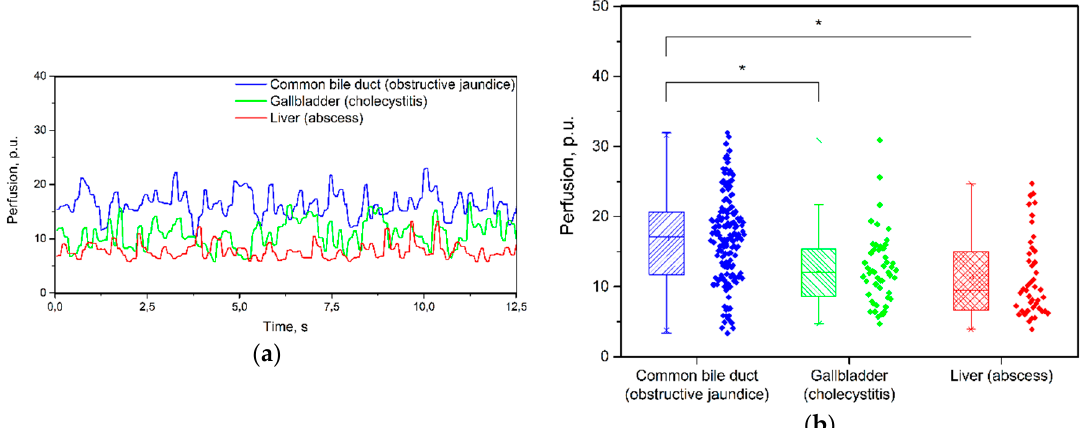
Table 2. Average values of LDF signals.